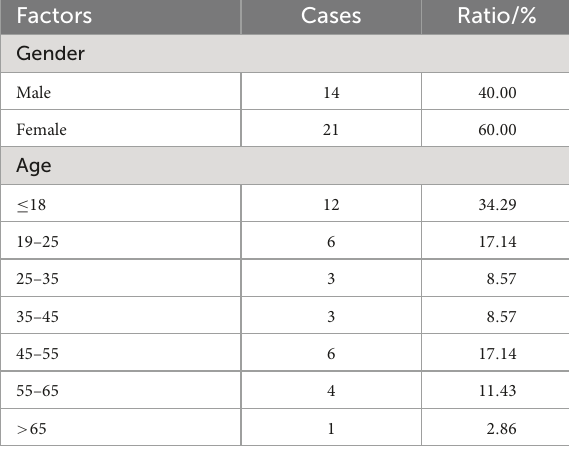
TABLE 3 Basic information of reported patients in 2021.